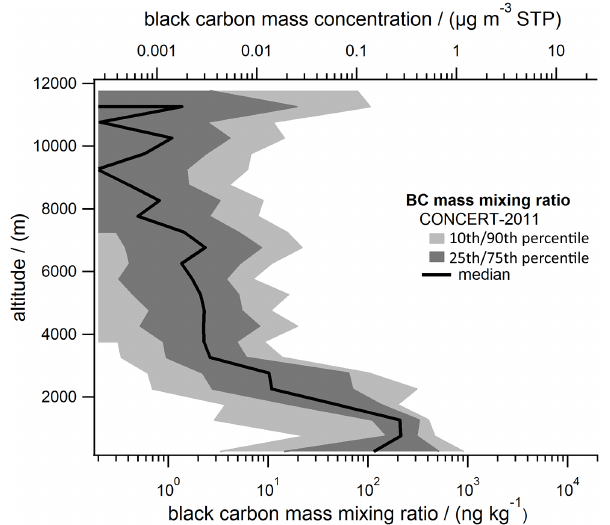
Figure 11. Vertical profile (STP) of the rBC mass mixing ratio (MMR) and rBC mass concentration (M) for all flights during CON- CERT 2011 measured with the SP2 as median (black), 25th/75th percentile (dark grey), and 10th/90th percentile (light grey) for 500m vertical intervals and a temporal resolution of 10s. Values are valid for the approximate size range of 80–440nm. The mass mixing ratio MMR was calculated from the mass concentration m (MMR [ngkg − 1 ] = m[ngm − 3 ]/1.29[kgm − 3